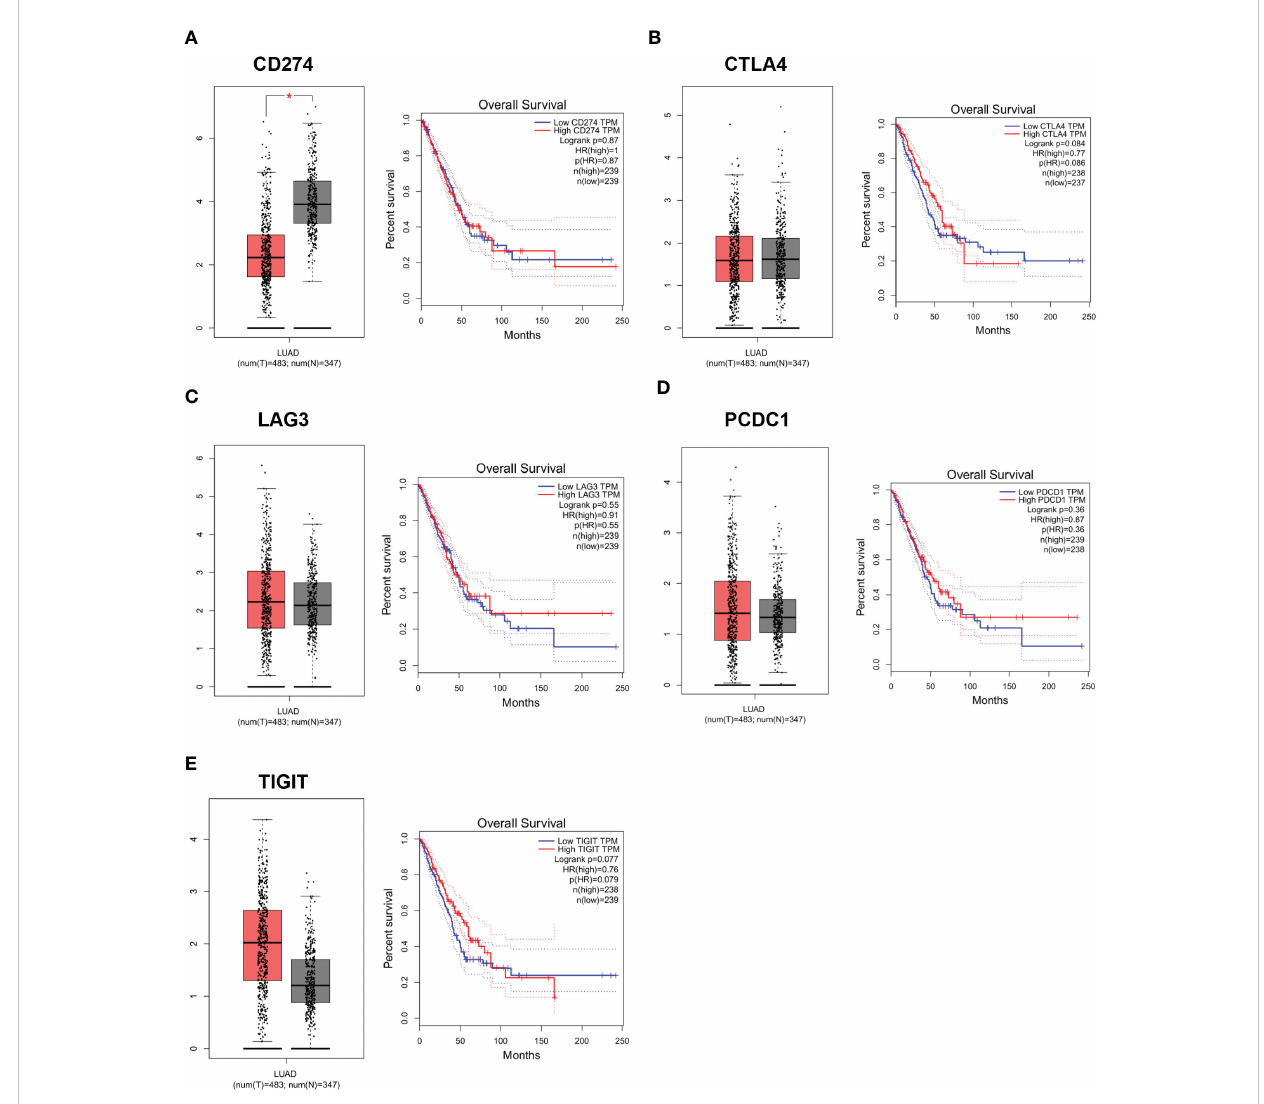
FIGURE 6 Expression levels and survival curves of genes in LUAD analyzed by GEPIA online database. (A) : Expression levels and survival curves of CD274 in LUAD analyzed by GEPIA online database; (B) : Expression levels and survival curves of CTLA4 in LUAD analyzed by GEPIA online database; (C) : Expression levels and survival curves of LAG3in LUAD analyzed by GEPIA online database; (D) : Expression levels and survival curves of PCDC1 in LUAD analyzed by GEPIA online database; (E) : Expression levels and survival curves of TIGIT in LUAD analyzed by GEPIA online